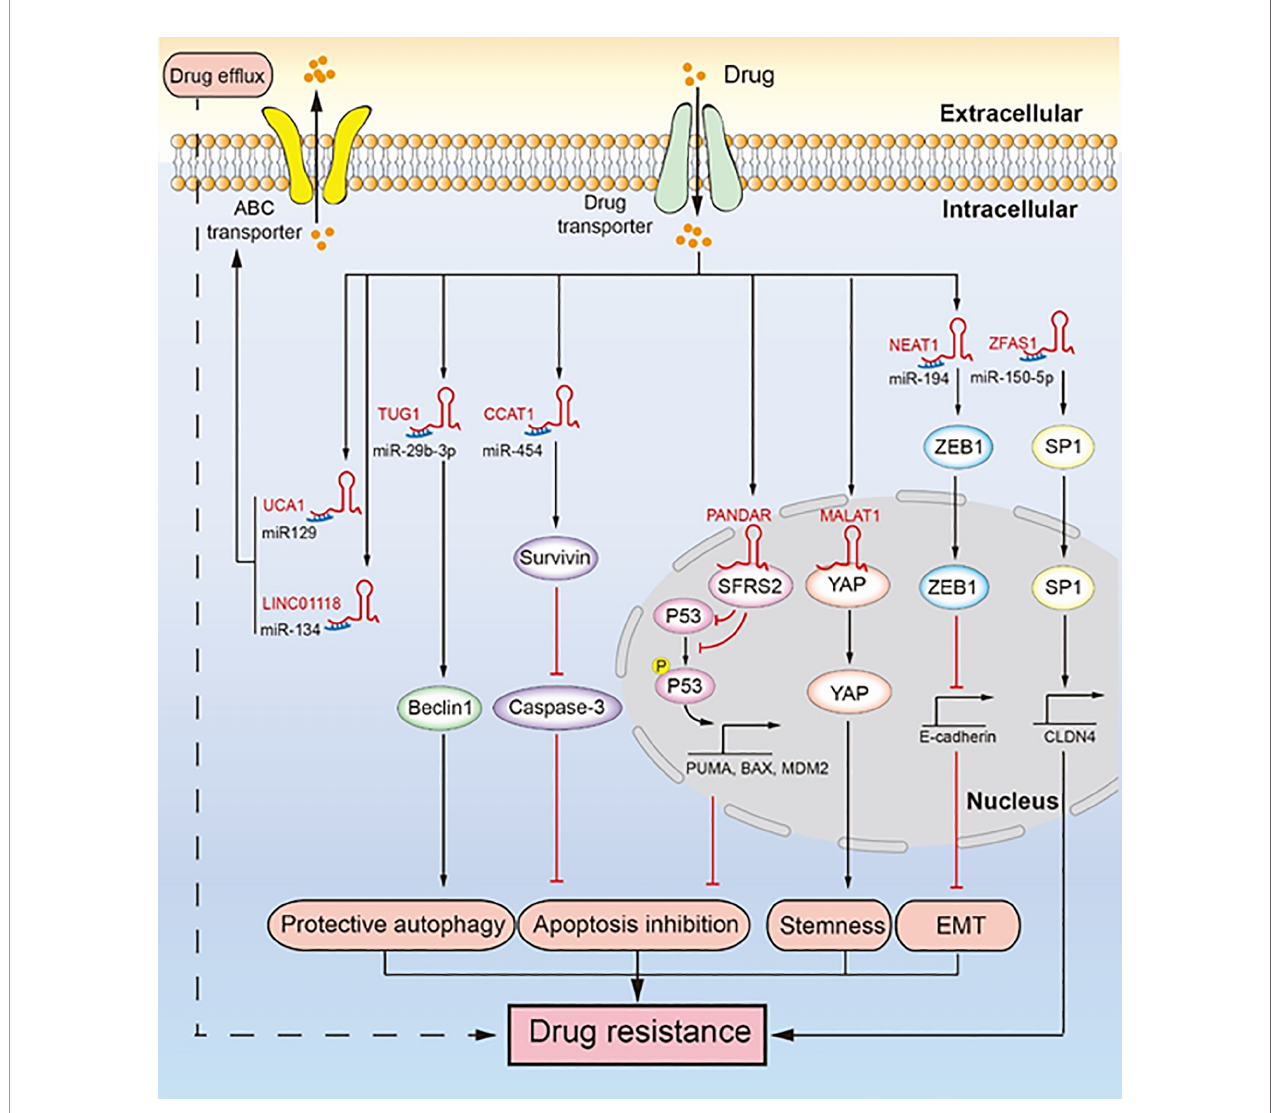
FIGURE 2 | LncRNAs regulate chemotherapeutic resistance through diverse signaling pathways. Multiple lncRNAs promote drug resistance by inducing drug ef fl ux, protective autophagy, apoptosis inhibition, tumor stemness, and epithelial-mesenchymal transition (EMT). LINC01118 and UCA1 regulate ABC transporters promoting drug resistance. TUG1 regulates Beclin1 leading to drug resistance induced by protective autophagy. CCAT1 upregulates survivin to inhibit the expression of caspase-3, which inhibits apoptosis and leads to drug resistance. PANDAR reduces the expression and phosphorylation of P53, inhibiting apoptosis and promoting drug resistance. MALAT1 binds YAP and inhibits its translocation from the nucleus to the cytoplasm, which facilitates cancer cell stemness leading to drug resistance. NEAT1 upregulates the expression of ZEB1, which promotes EMT leading to drug resistance. ZFAS1 promotes the transcription of CLDN4 to upregulate SP1, which leads to drug